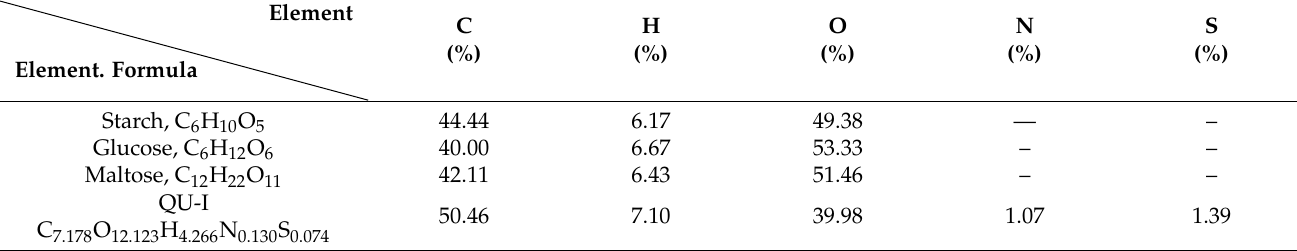
Table 5. Percentage (mass) content of individual elements in 1 Mg of maize grain as derived from the elementary formula. Element Element. Formula Starch, C 6 H 10 O 5 Glucose, C 6 H 12 O 6 Maltose, C 12 H 22 O 11